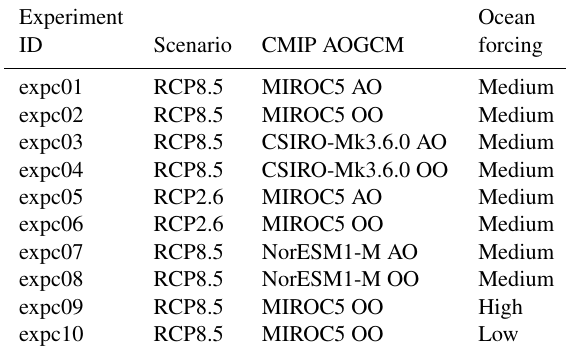
Table A6. Description of ISMIP6 Greenland Tier 3 simulations, which are performed with ocean-only (OO) or atmosphere-only (AO) forcing, as indicated in the CMIP AOGCM column.